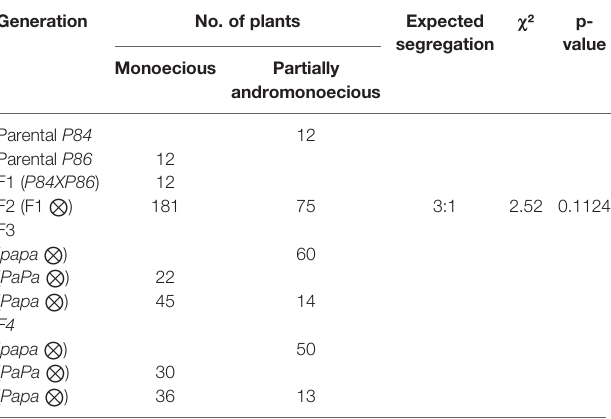
TheF2,F3andF4plantswerephenotypedonthebasisoftheiraverageAI,scoredfromat least 10 fl owers per plant. Monoecious (1 ≤ AI ≤ 1.35) and partially andromonoecious (1.35<AI<2.7). Thegenotypes forthepartial andromonoecious locus(PA/pa)in F3and F4 generations were assigned on the basis of the segregation ratio. ⨂ ,